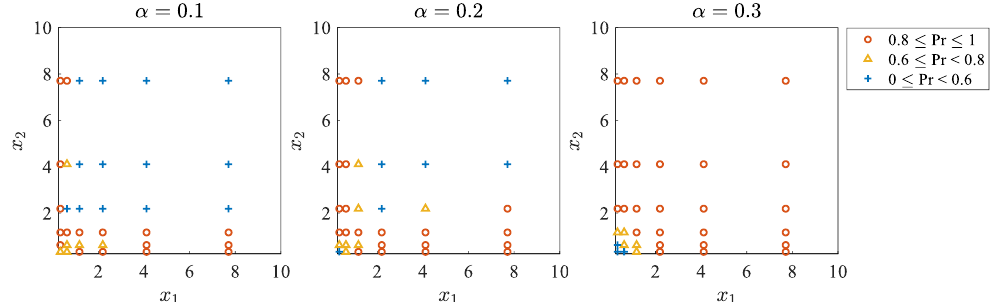
Figure 7. The frequencies of capturing different optimal solutions among 100 replications with varying α in Problem F5(2D). The budget size is 8000. As the α value increases, the frequency of finding optima in steep areas is reduced while the frequency of finding optima in flat areas is